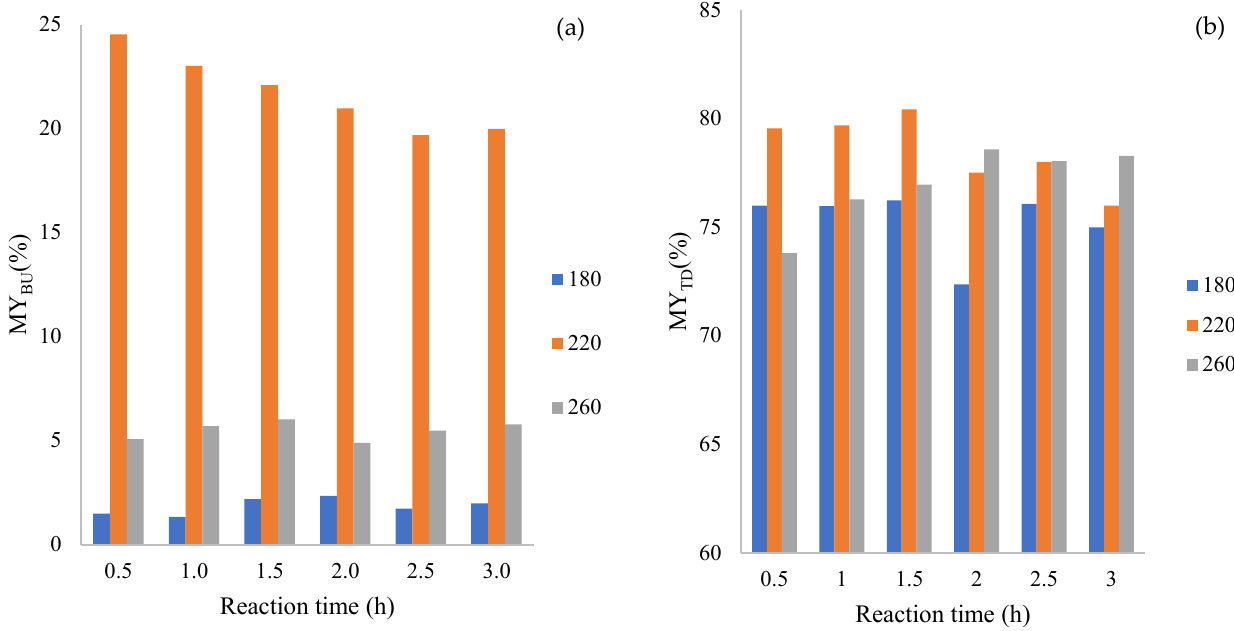
Figure 1. Mass yields calculated for bottom-up and top-down CD synthesis methods at different temperature. Mass yield is considered the mass percent of CD produced and is calculated based on dry mass in vs. dry mass out, assuming that all mass loss is CD material. ( a ) Mass yield for bottom-up process per temperature and time conditions of given trial. ( b ) Mass yield for top-down process per temperature and time conditions of given trial. Please note that the temperature is reported as ◦